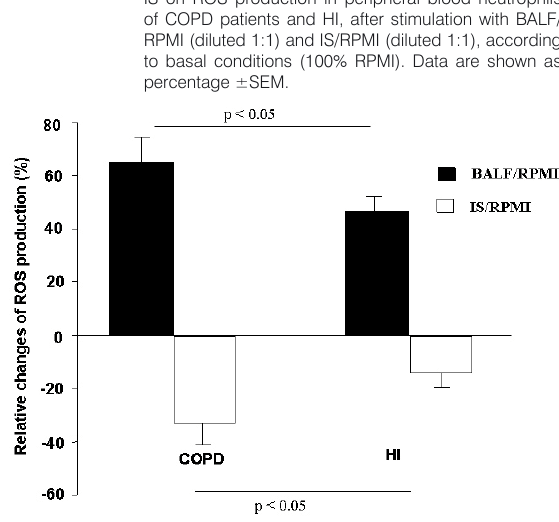
Figure 6. A histogram, representing relative changes of ROS production in peripheral blood neutrophils, stimulated with S. aureus bacteria, opsonized S. aureus bacteria and their combination with BALF (diluted 1:1) and IS (diluted 1:1), according to basal conditions (100% RPMI).